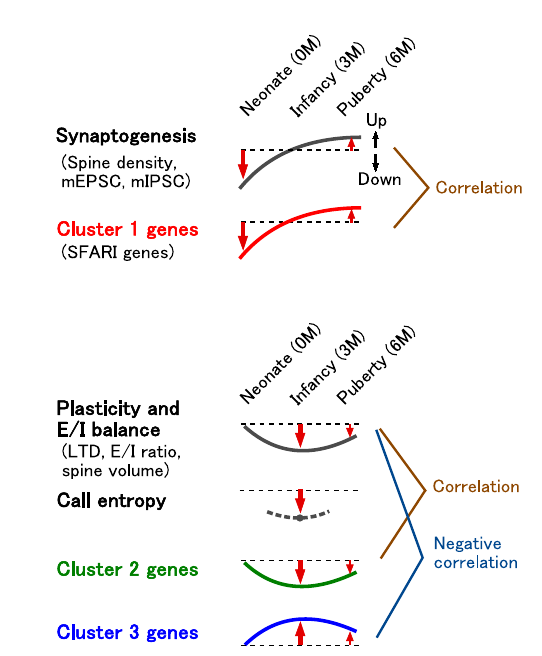
Fig. 6 Summary of the results. Synaptogenesis-related phenotypes, including modulations in spine density and miniature synaptic current frequencies, were correlated with modulations in the expression of cluster 1 genes, which include SFARI genes. The E/I balance and plasticity-related phenotypes, including modulations in the E/I ratio, LTD (post-LFS fi eld EPSP), and spine volume, were correlated with modulations in cluster 2 genes and inversely correlated with modulations in cluster 3 genes. The entropy of calls was reduced at infancy when cluster 2 and 3 genes were maximally after complete maturation of the circuit may be different from the phenotypes we observed until puberty; moreover, different ther- apeutic approaches may be needed for infantile and adult people with ASD. Future research on phenotypes at later times into adulthood and in different areas or layers will provide further insight into ASD pathology.